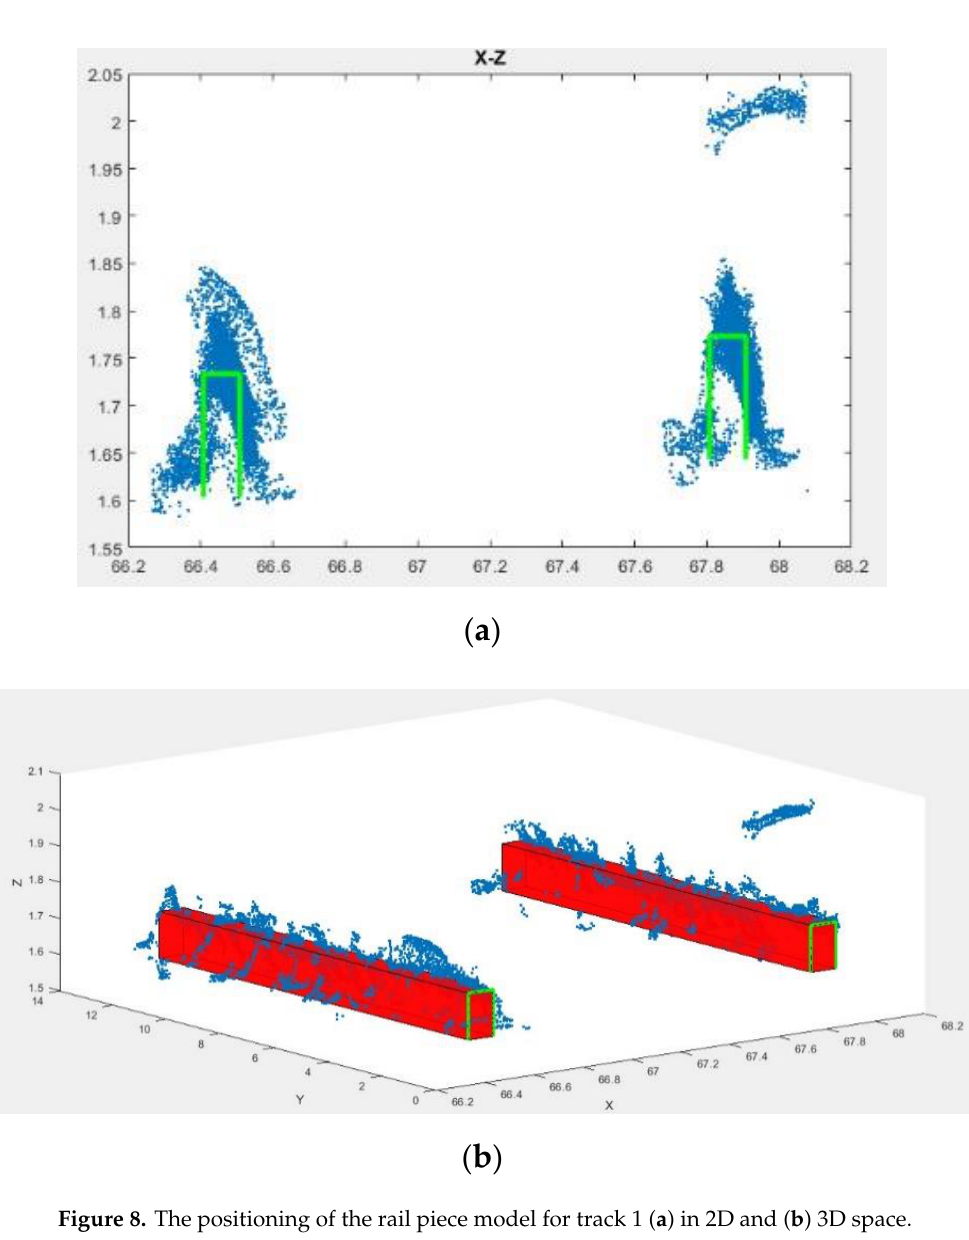
Figure 8. The positioning of the rail piece model for track 1 ( a ) in 2D and ( b ) 3D space. According to the design parameters, the values of the X and Z of the model for rail track 1 are 7 cm and 13 cm, respectively. For tracks 2 and 3, due to the presence of the surrounding ballast, the visible height of the model is considered to be 7 cm. After determining the two-dimensional position of the model, by adding the value of Y at the end of each piece, the models are transferred to the three-dimensional space (Figure 8b). In the final step, in order to integrate all pieces into each other to form a unified final model, each of the five model parameters is interpolated separately using the Fourier series. Therefore, in order to prevent oscillation and waviness in the final model, the use of higher degrees of the Fourier function is avoided [11]. The final three-dimensional model of rail tracks using the proposed method is presented in Figure